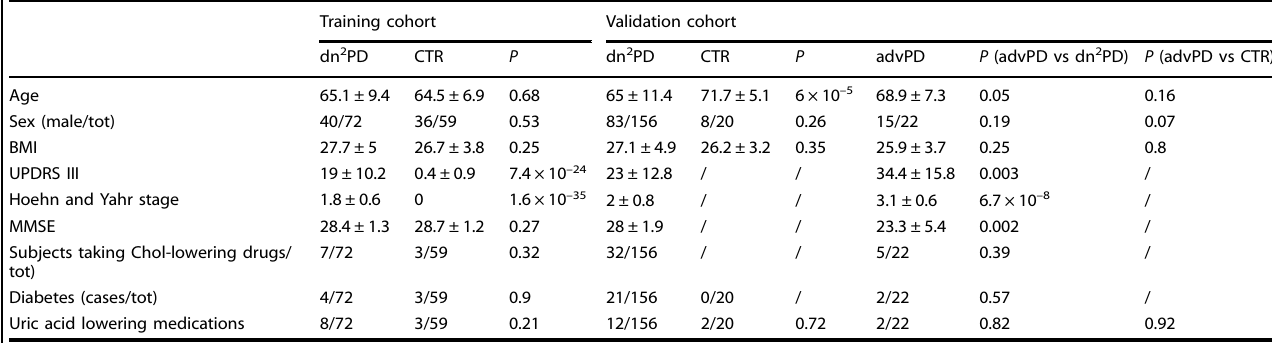
Table 4. Demographic characteristics of the population under